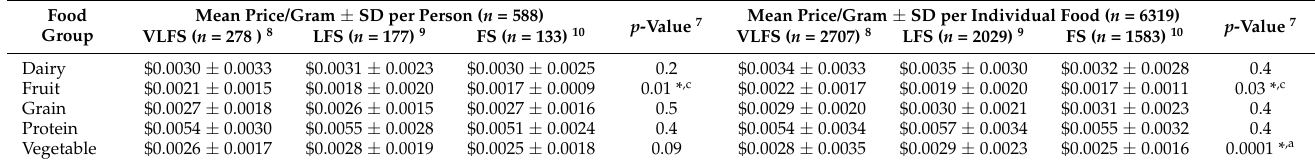
Table 4. Mean price per gram for reported 24-h dietary intake by food group among adults using rural, Midwestern food pantries recruited in 2014 6